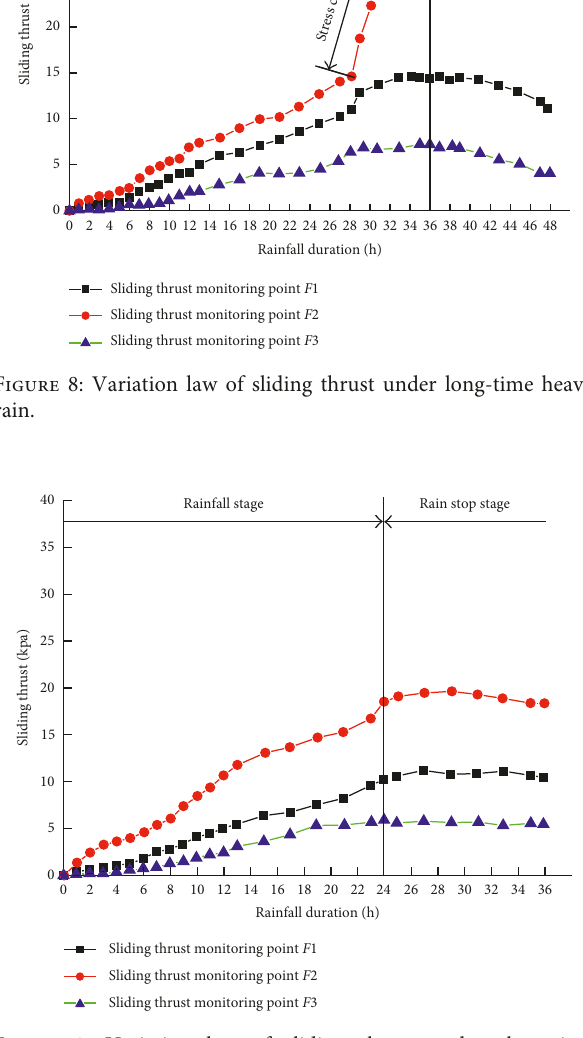
Figure 9: Variation law of sliding thrust under short-time